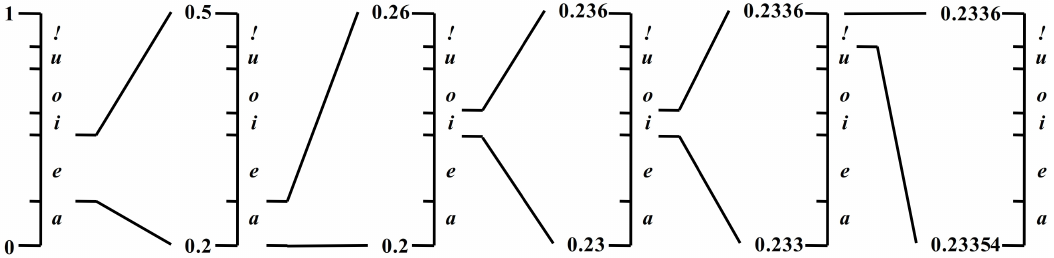
Figure A1. Symbols ranges in Arithmetic encoder for the message ‘eaii!’.